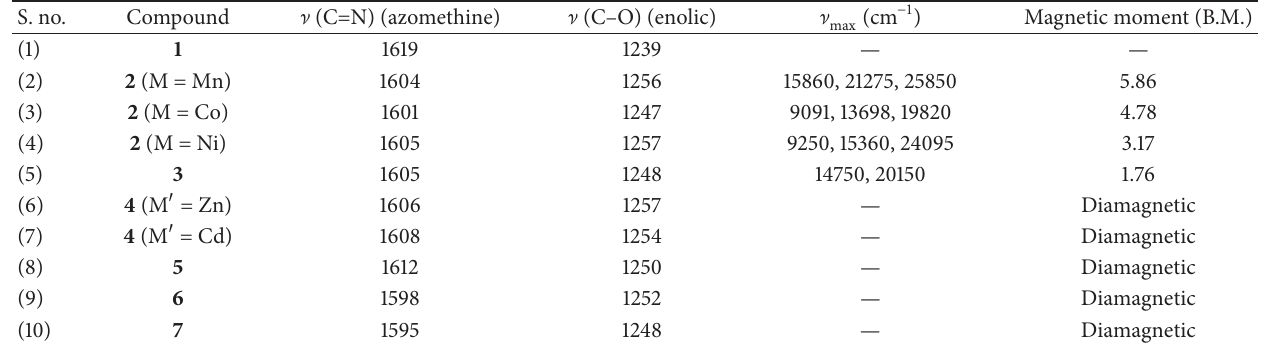
Table 2: IR, reflectance spectral data (cm − 1 ), and magnetic moments of the coordination compounds.